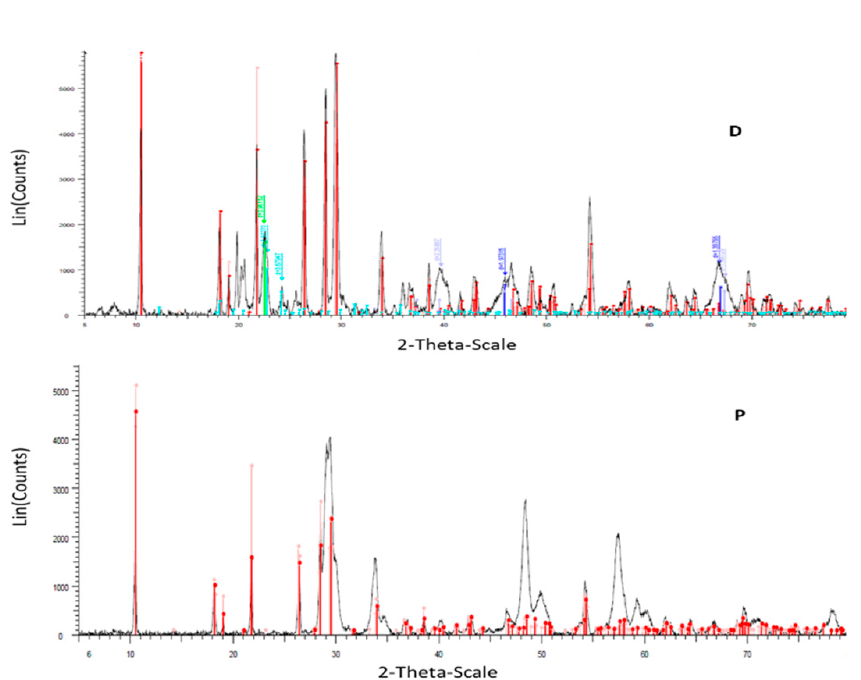
Figure 3. XRD pattern powder diffraction pattern for the spent catalyst converters confirming the presence of cordierite in the investigated samples of Diesel (D) and Petrol (P) catalytic converters.